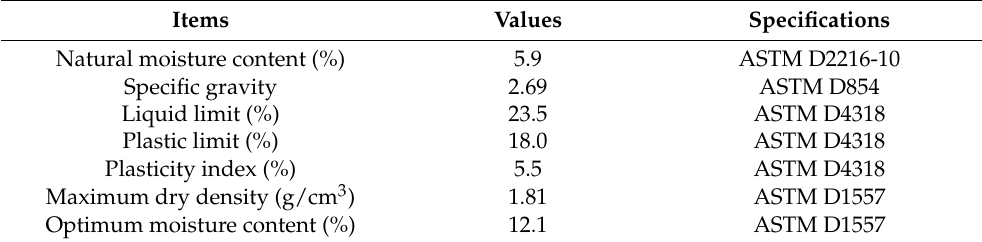
Table 2. Physical indexes of soil.